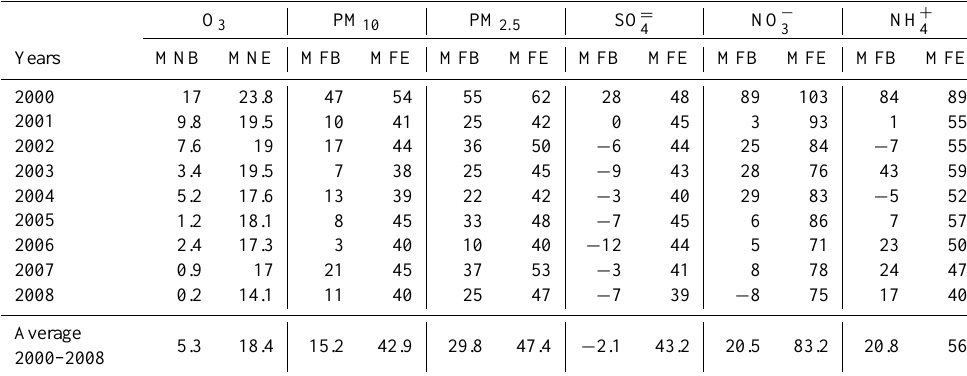
Table 2. Operational evaluation of the model using the criteria ∗ of Russell and Dennis (2000) for O 3 and of Boylan and Russell (2006) for PM and its components (expressed in